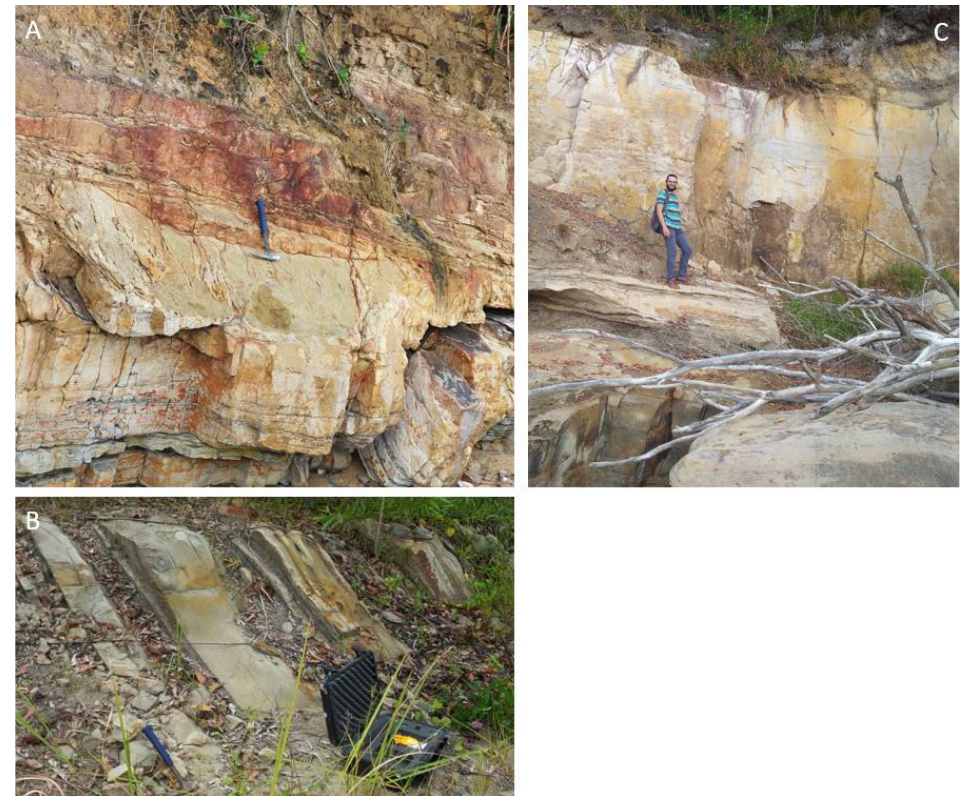
Figure 2. ( A ) The upper Belait Formation sandstone with coal intercalations, ( B ) the interbedded fine-grained sandstone of the Temburong Formation, and ( C ) the lower Belait Formation massive sandstone.